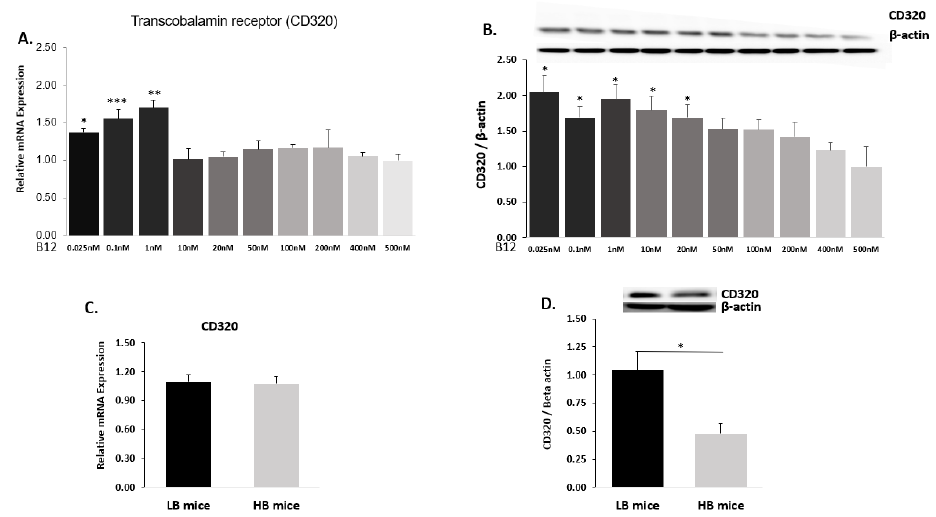
Figure 2. Transcobalamin receptor (CD320) mRNA expressions and protein levels in Hep G2 and liver tissues: ( A ) The mRNA expression of transcobalamin receptors (CD320) normalized to 18S rRNA endogenous control and ( B ) CD320 protein levels related to β-actin in Hep G2 cells at ten different B12 concentrations (500 nM (control), 400 nM, 200 nM, 100 nM, 50 nM, 20 nM, 10 nM, 1 nM, 0.1 nM and 0.025 nM). ( C ). The CD320 mRNA expression in liver tissues of HB and LB mice normalized to L19 endogenous control and ( D ) CD320 protein levels related to β-actin in liver tissues of HB and LB mice. The data are representative of mean ± SEM ( n = 6) and * indicates significance compared to the control; * p < 0.05, ** p < 0.01, *** p < 0.001.